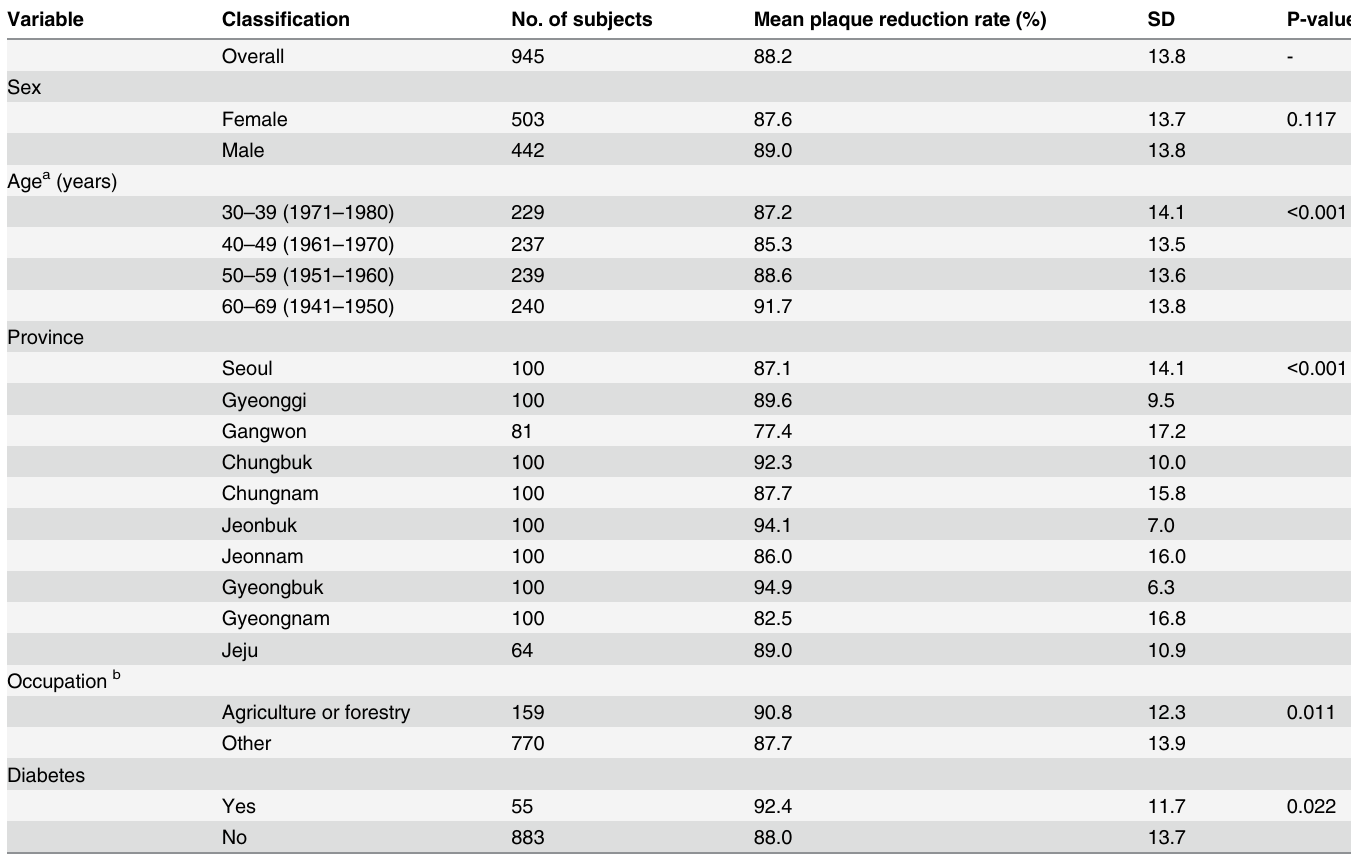
Table 4. Plaque reduction rate to Japanese encephalitis